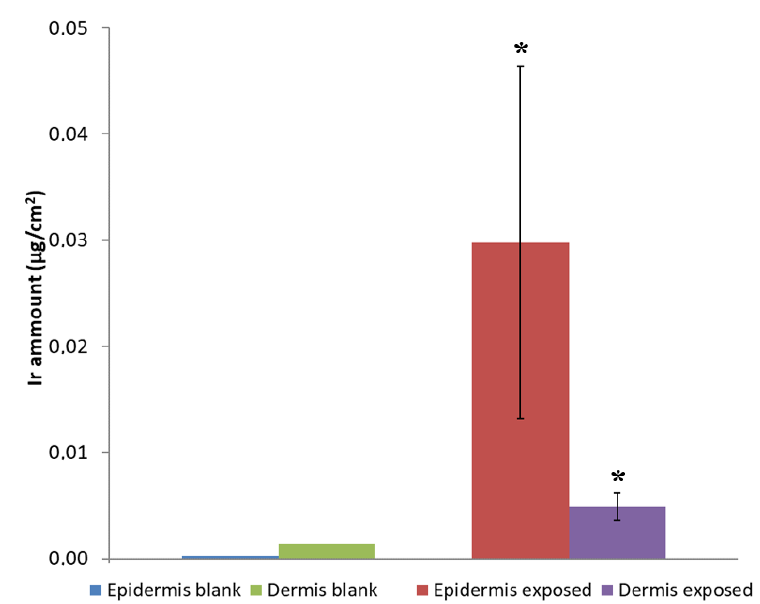
Figure 9. Ir distribution within human skin in blank and treated samples as determined by ICP-MS. (* values are significant different from the blank with p < 0.05).